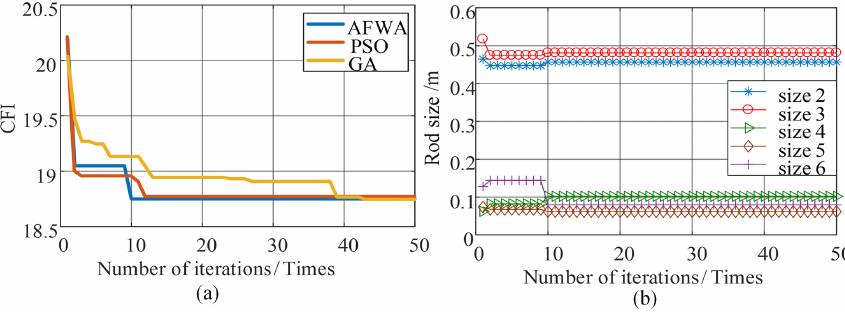
Figure 11. Particle evolution diagram with CFI as optimization target. (a) CFI index evolution diagram. (b) Particle evolution diagram for each link size. Table 2. Dimensions of links obtained by different optimization objectives.